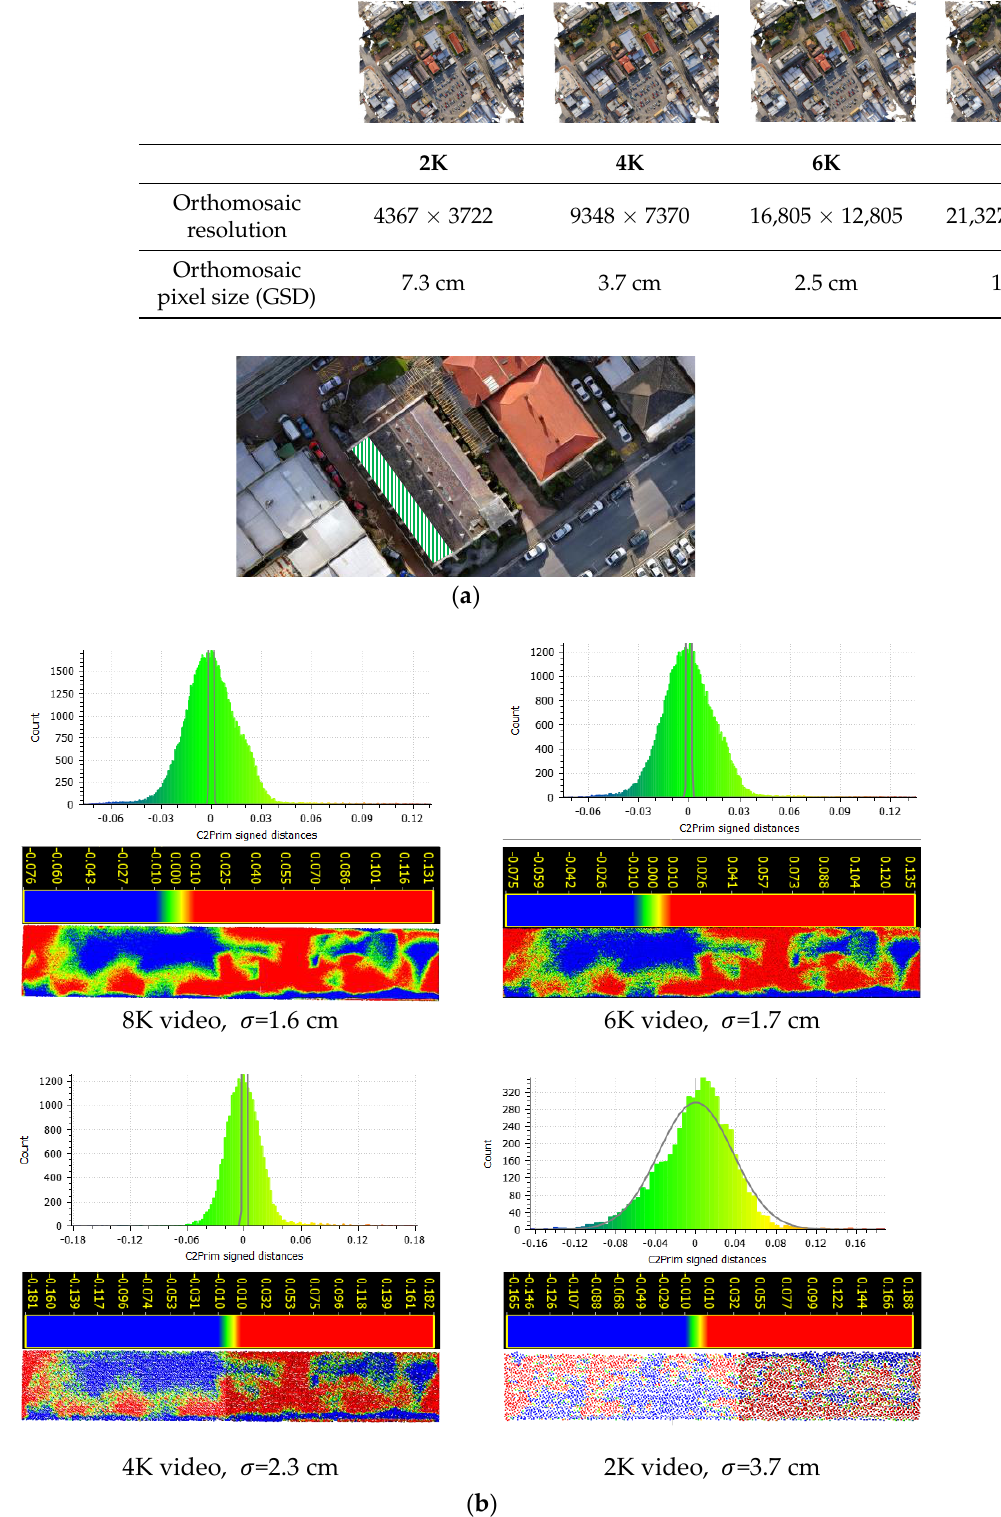
Figure 10. Checking the internal accuracy of the first test. ( a ) The selected planar roof (dashed area) for testing the relative accuracy. ( b ) Planar fitting relative error evaluation at the four video resolutions (red > 1 cm, blue < − 1 cm).